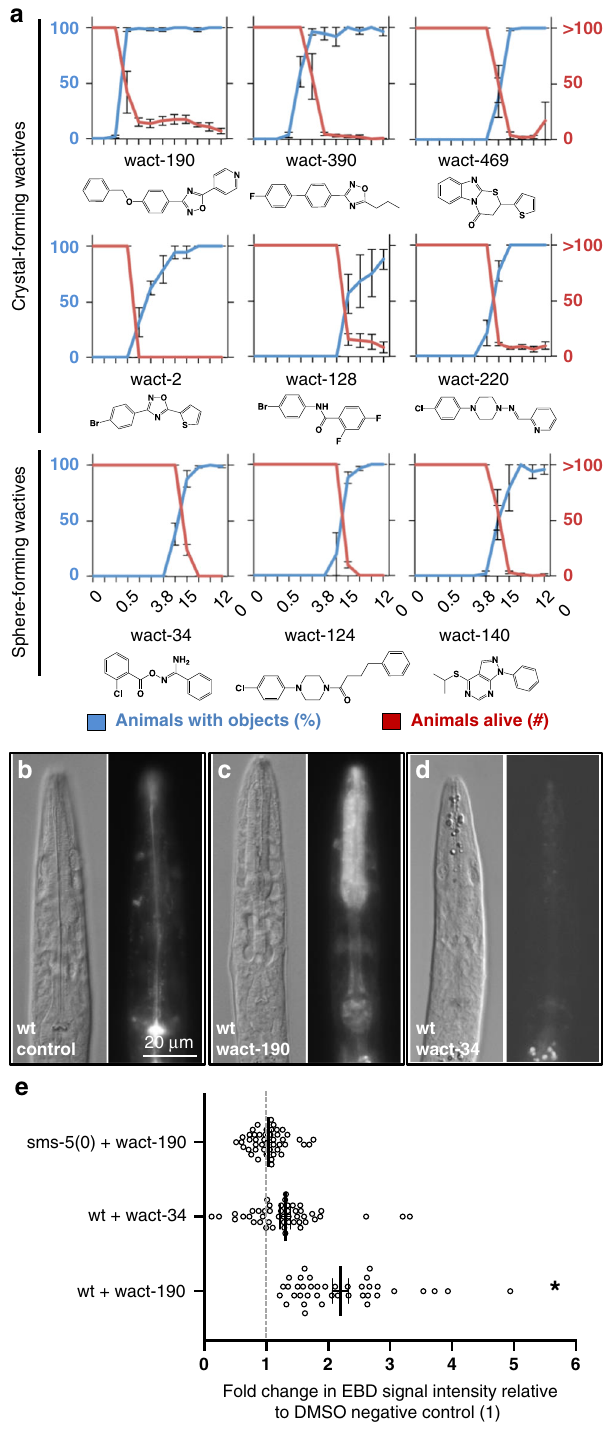
spectrometric analysis (Fig. 5e). The sms-5 null mutant also resists Evans Blue dye penetration into the anterior pharynx when co- incubated with wact-190 (Fig. 2e).